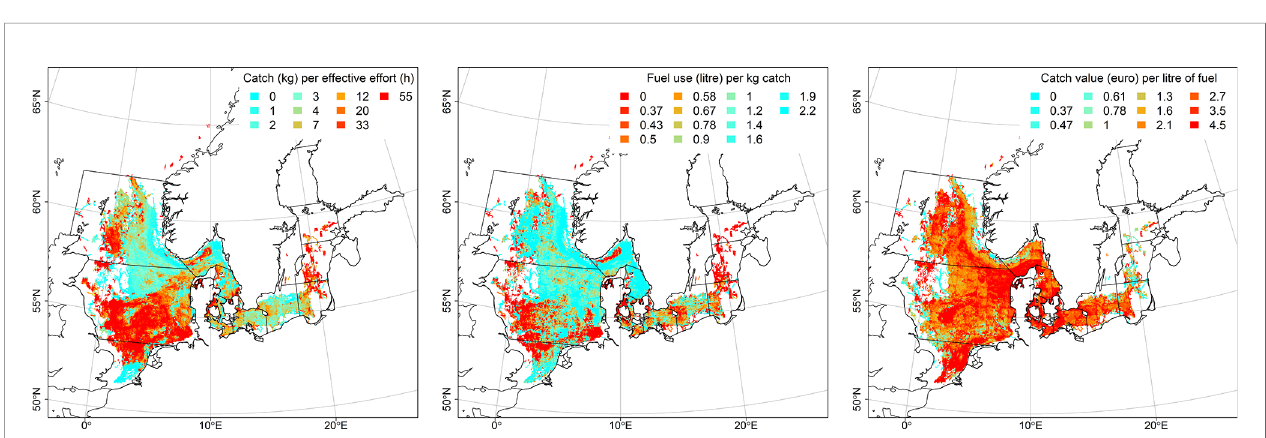
FIGURE 4 | Average of indicators for bottom-contacting gears deployed during 2005-2019 by Danish fl eets (in FAO 22.3 Baltic Sea, 22.4 North Sea, and part of 22.2, effort in other areas, e.g. Icelandic Waters, or EU Western Waters are not shown) aggregated on 1x1 minute grid cells. The larger grid corresponds to the FAO areas